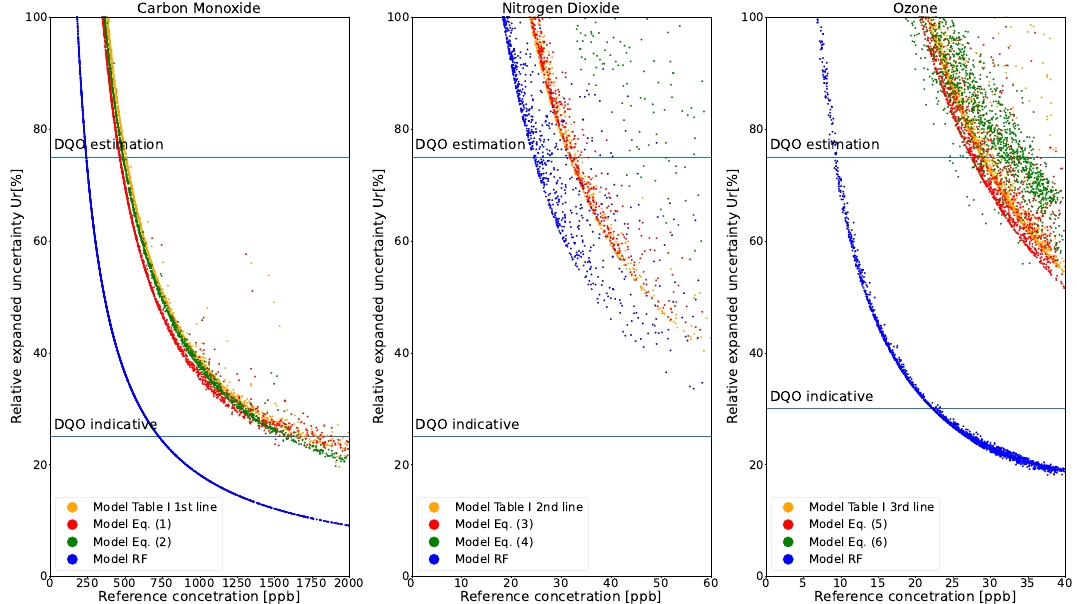
Figure 4. Relative uncertainty of the different calibration models versus reference measurements with a coverage factor of